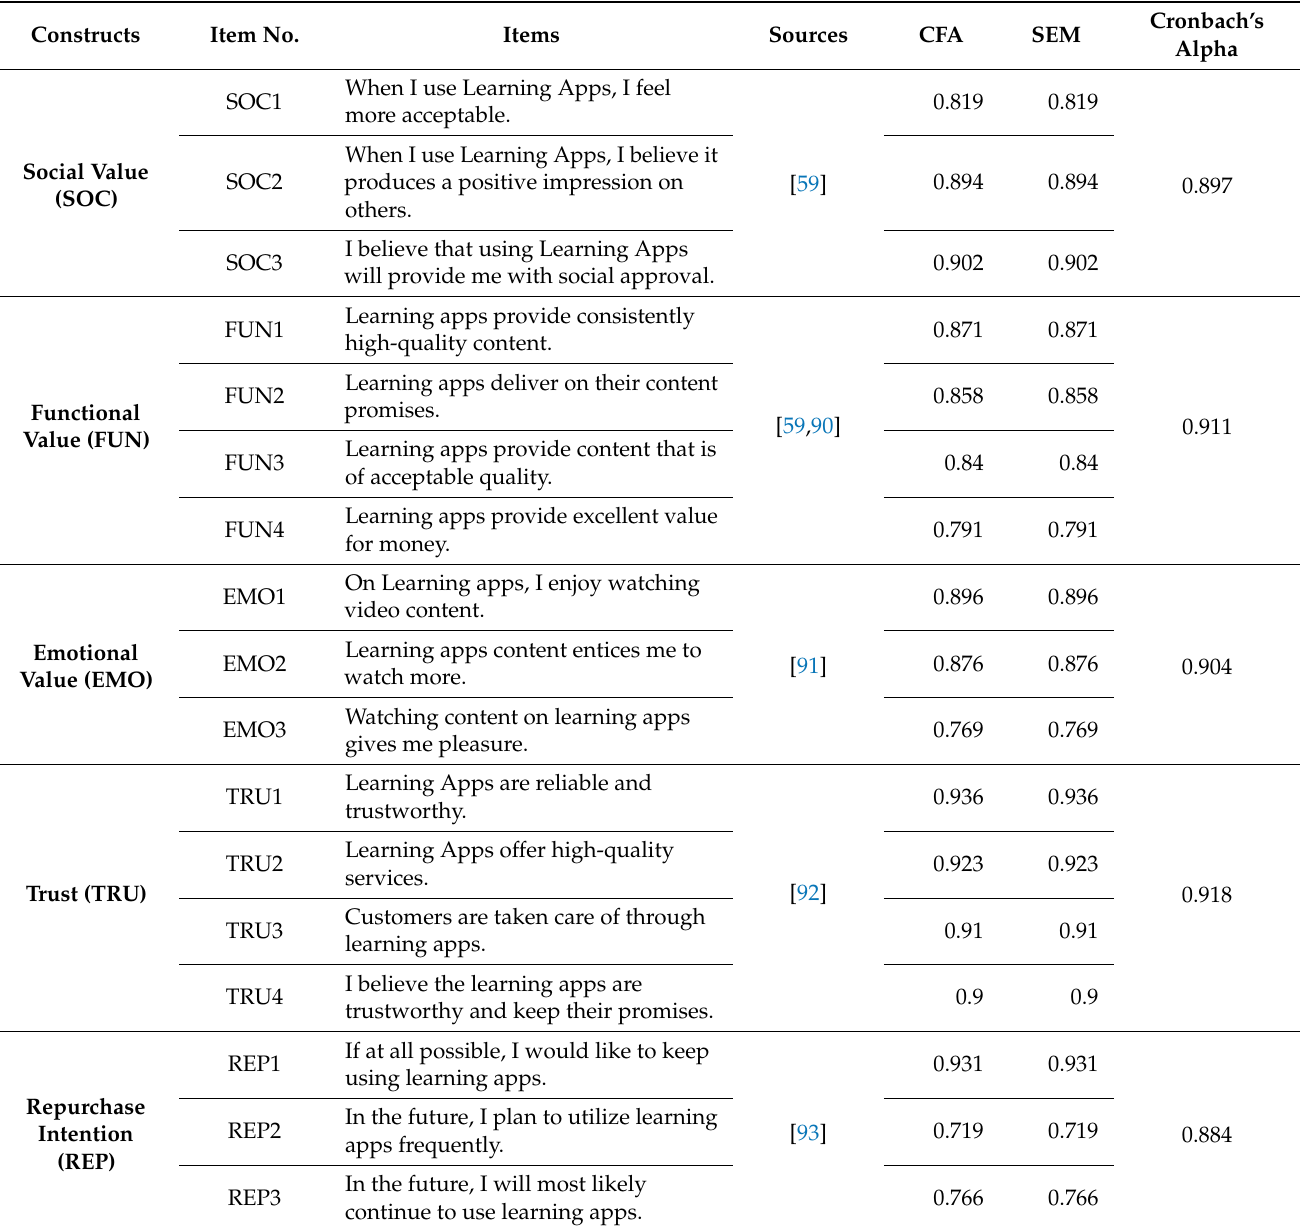
Table 2. Constructs and Factor